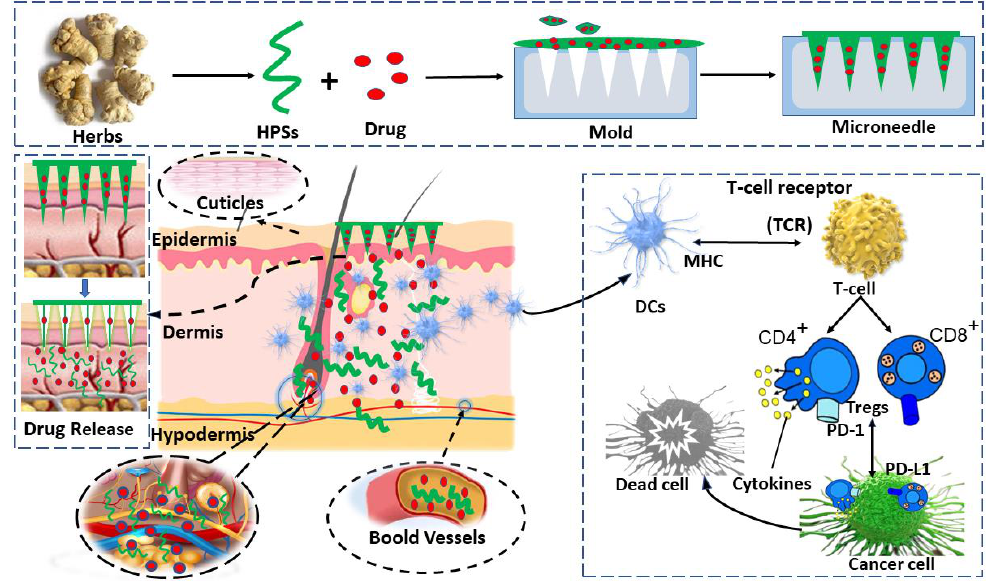
Figure 3. Fabrication and applications of HPS-based DMNs.